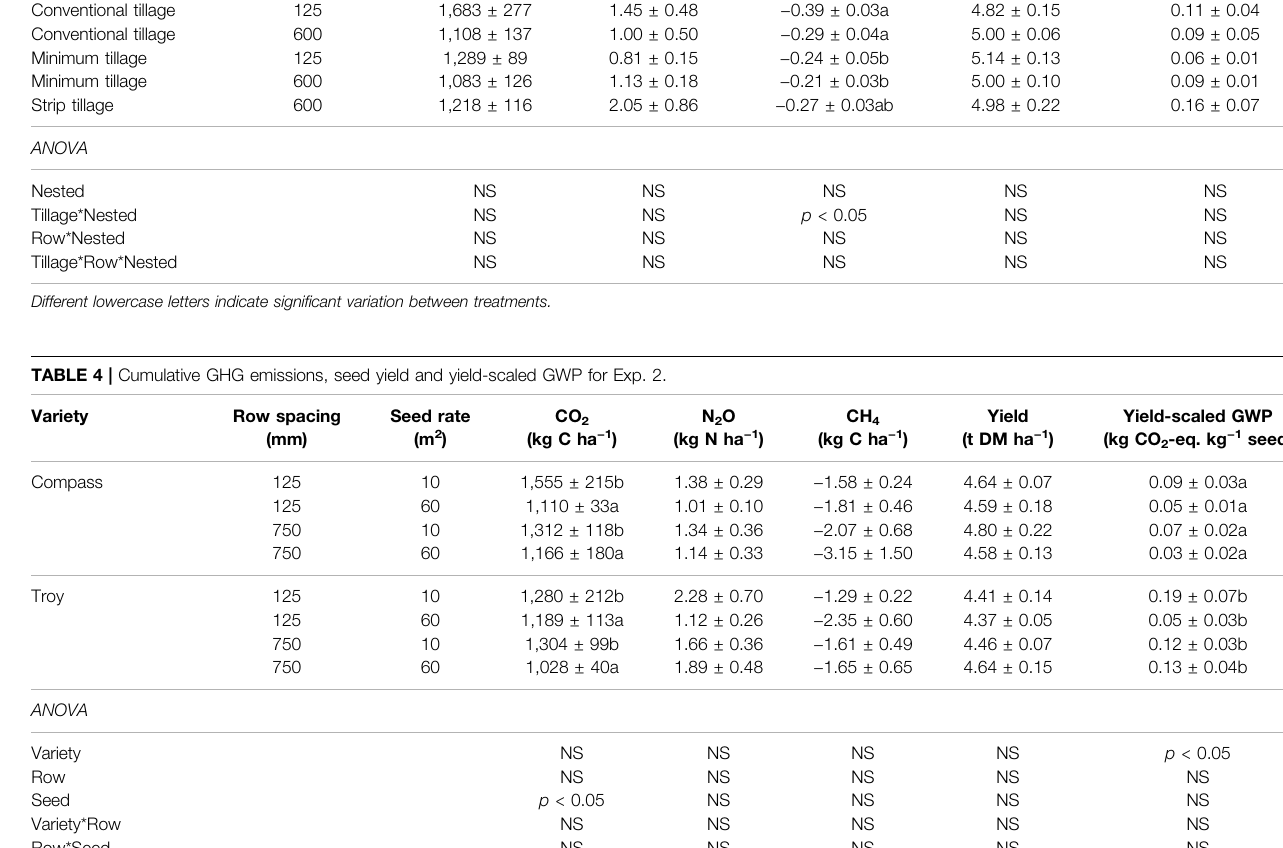
Different lowercase letters indicate signi fi cant variation between treatments.